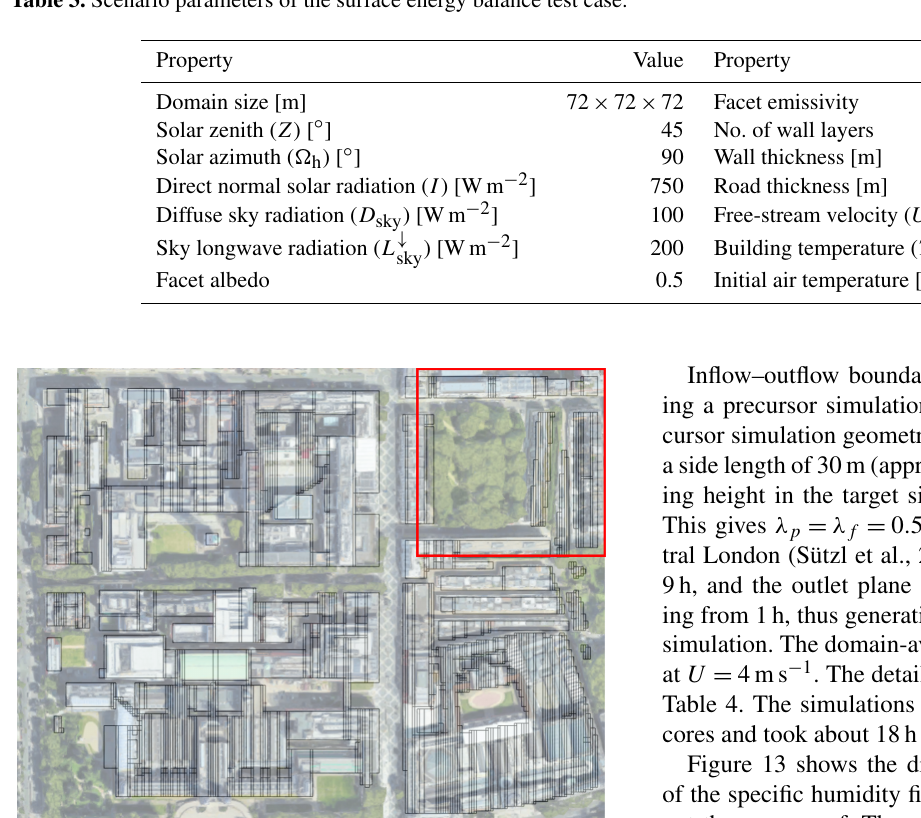
Table 3. Scenario parameters of the surface energy balance test case.